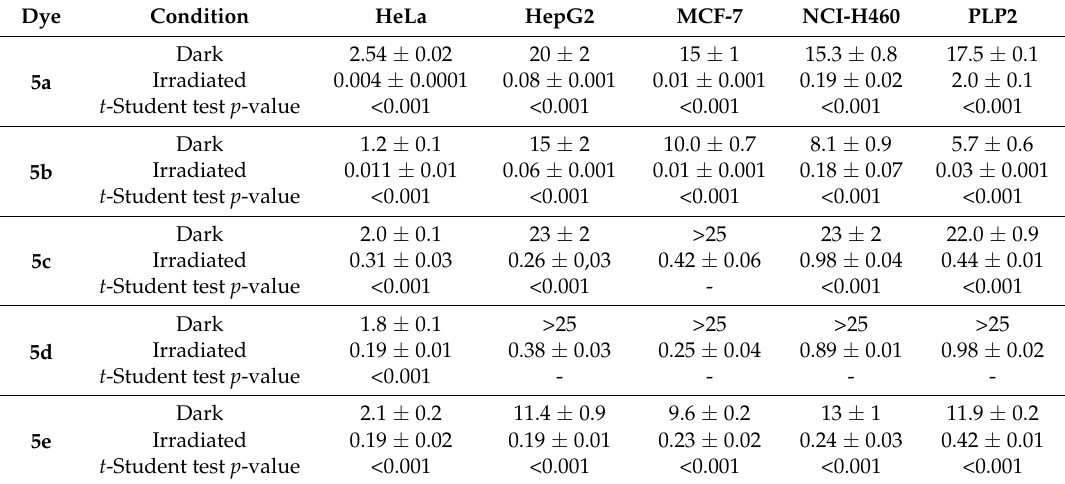
Table 2. Cytotoxicity (GI 50 values, µ M) of aminosquaraine dyes 5a – e (mean ± SD). Dye Condition